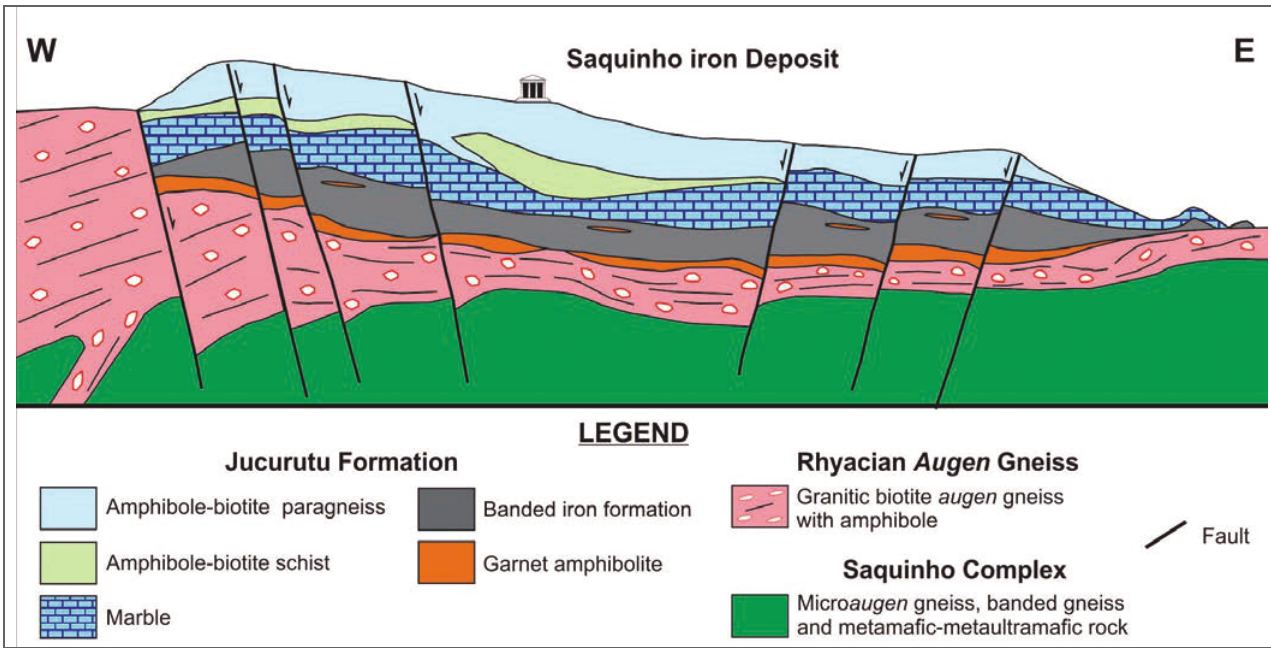
Figure 19 - Geological model of the Saquinho mine region (without scale), emphasizing the metasediments of the Jucurutu Formation superimposed on a basement composed of Rhyacian and Archean